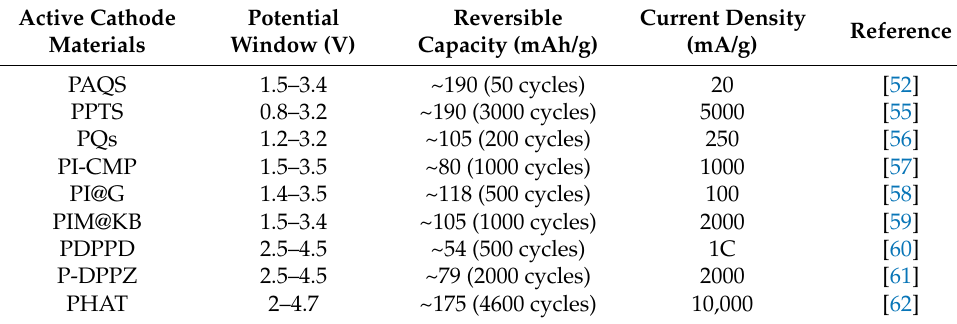
Table 1. The performance of polymer cathodes for